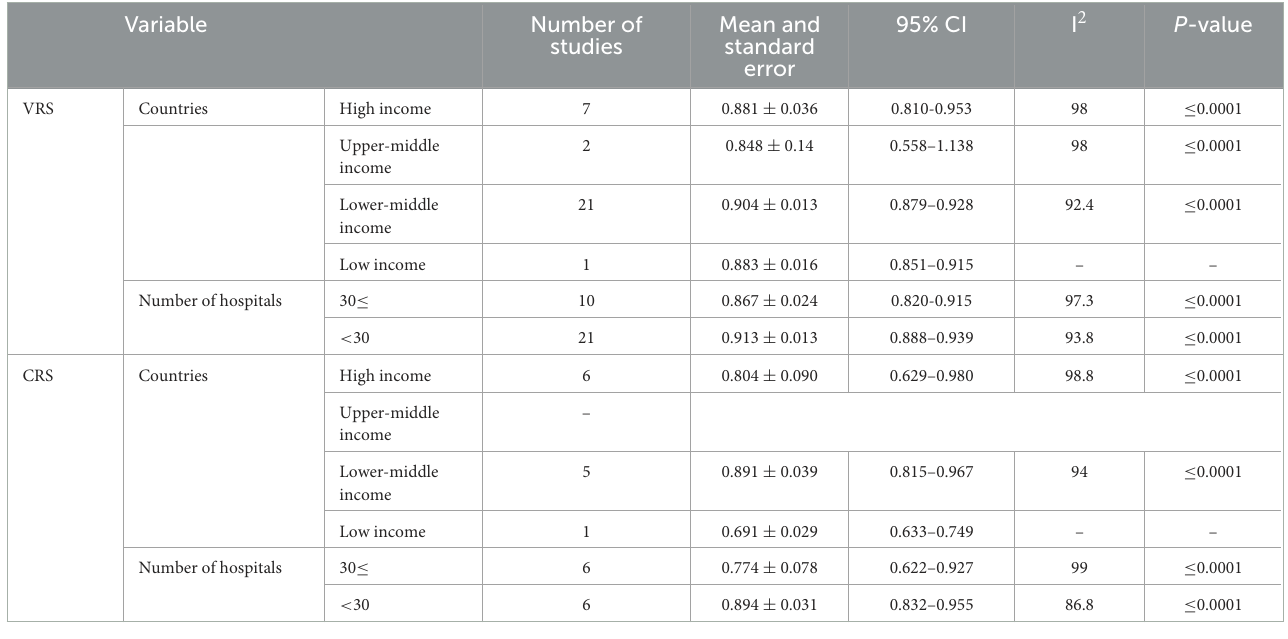
TABLE 3 Subgroup analysis of efficiency scores by country and method of analysis.